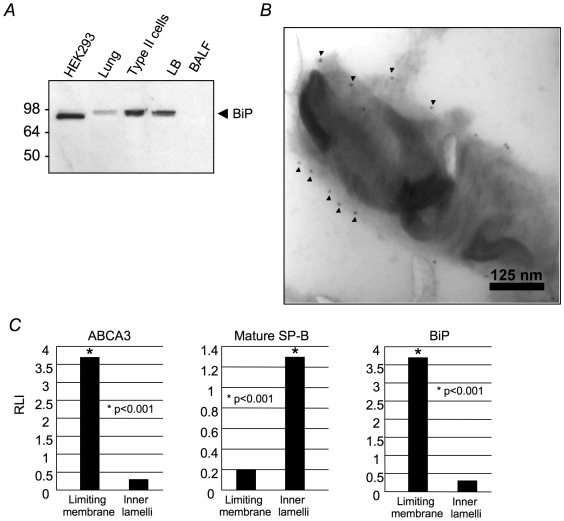
BiP distribution in LBs.(A) Western blot for BiP in HEK293 cells, whole lung, isolated type II cells, isolated LBs and BALF. Samples were normalized to protein content. (B) Immunogold labeling for BiP in isolated rat LB. (C) Relative labeling index (RLI) of isolated rat LBs labeled by immunogold for ABCA3, mature SP-B and BiP.